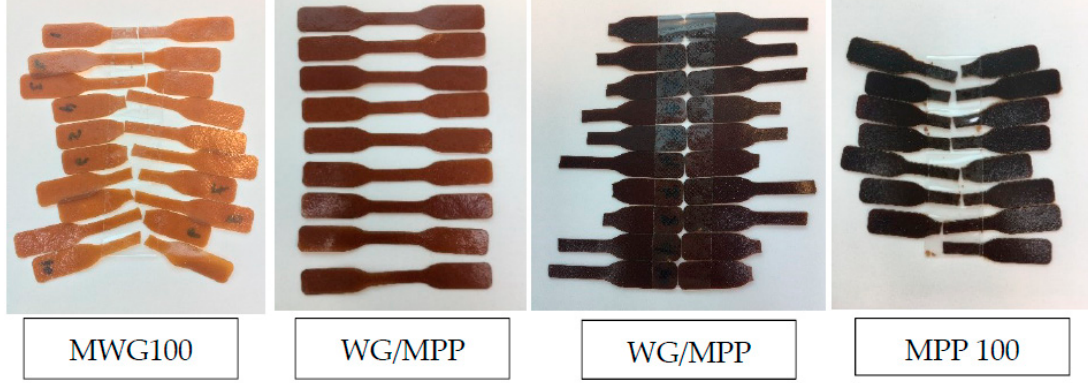
Figure 4. Representation of the range of colors of films and composites MWG100, WG/MPP 70/30, WG/MPP 30/70 and MPP100 pressed at 130 °C.